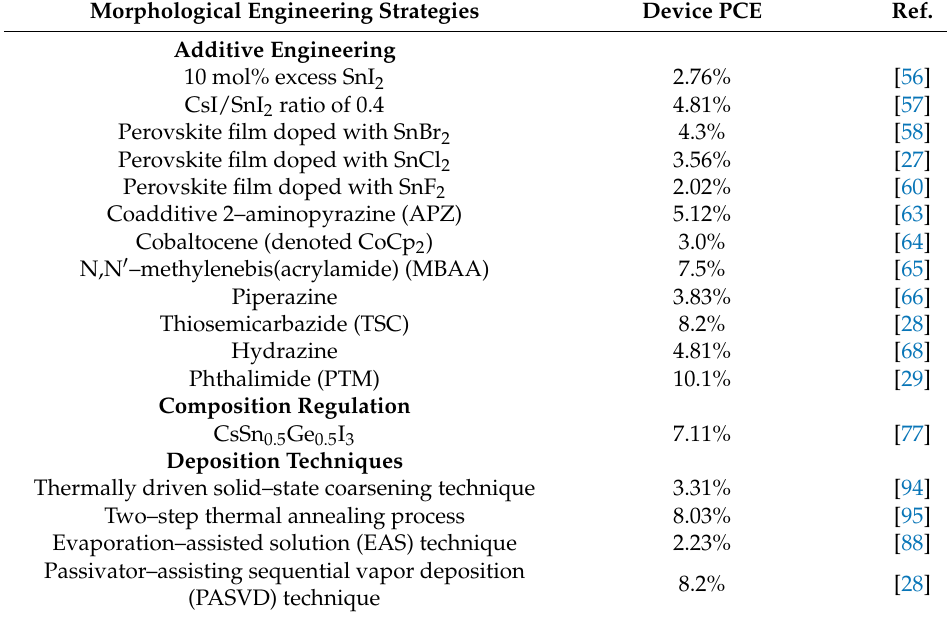
Table 1. Summary of morphological engineering strategies for CsSnI 3 PVSCs. Morphological Engineering